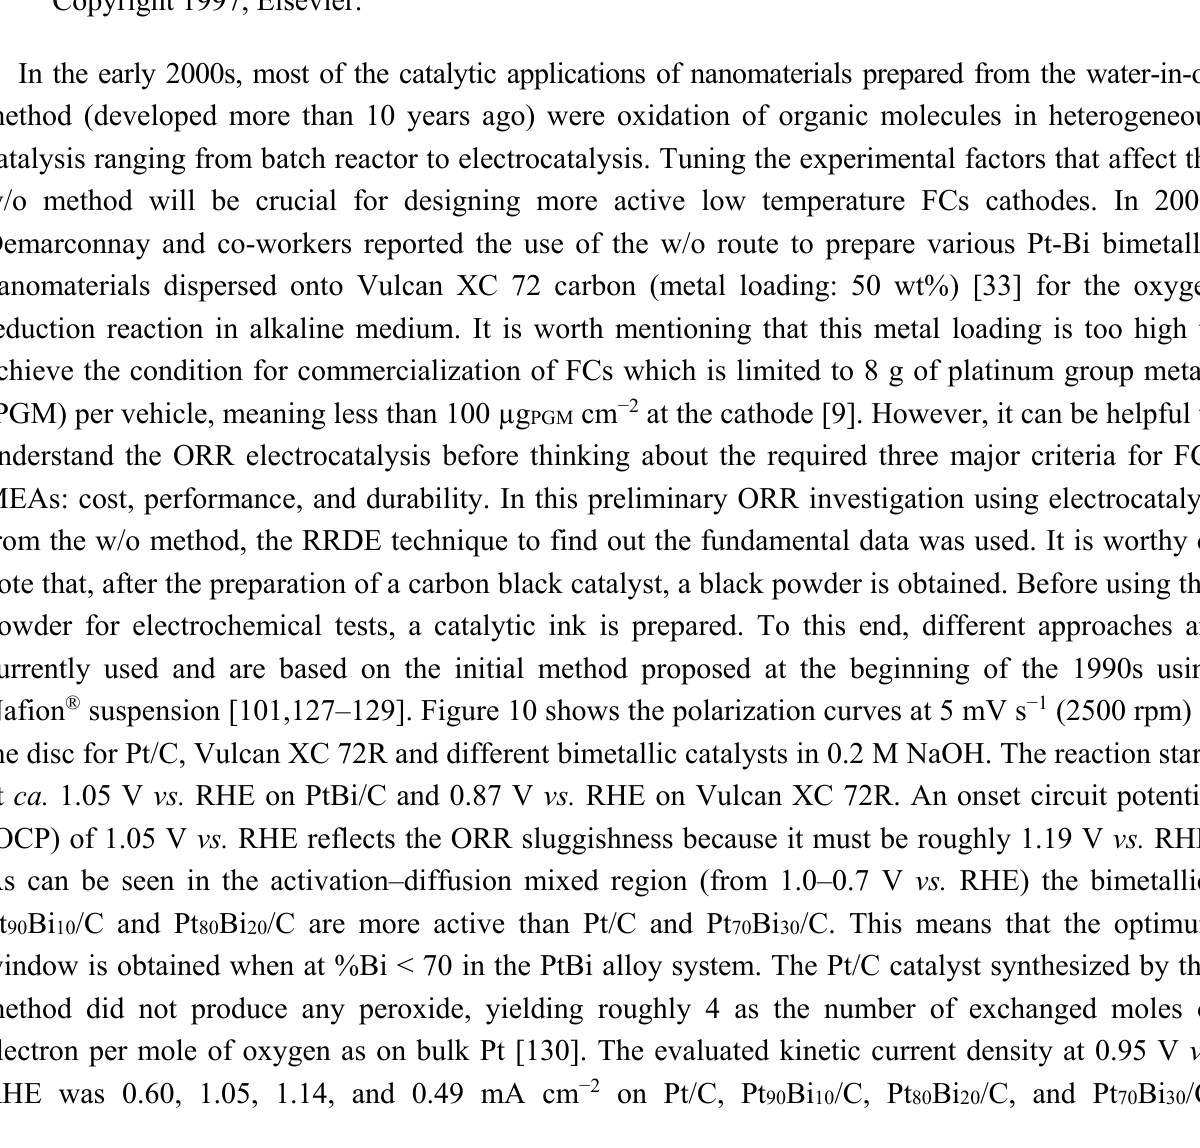
Figure 9. Schematic representation of the oxygen reduction reaction (ORR) mechanism by direct pathway (A: adsorption parallel to the surface) and indirect pathway (B: adsorption perpendicular to the surface). Reprinted and adapted with permission from Ref.